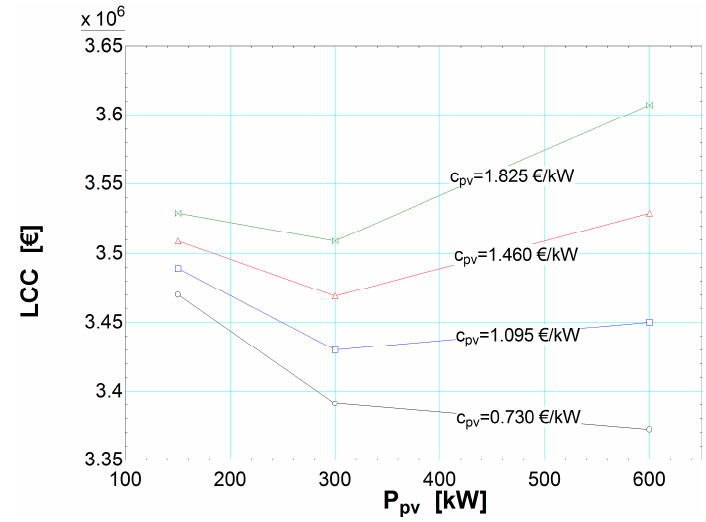
Figure 10. Effect of the specific cost for the photovoltaic subsystem on the lifecycle cost of the proposed system.